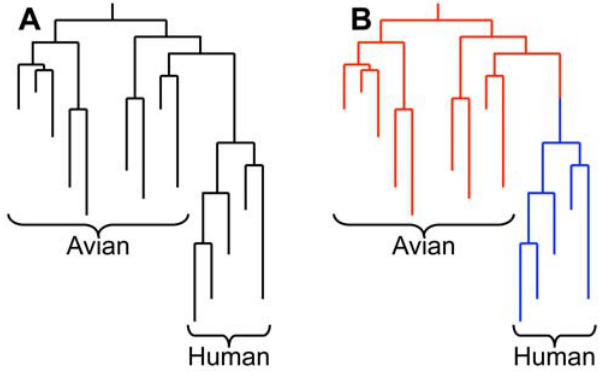
Figure 2. Homogeneous and non-homogeneous substitution models. Illustrative phylogenetic trees showing set of avian and human influenza sequences. A: In the homogeneous models (Models 1 and 2), the same substitution rates are used throughout the tree. B: In the non-homogeneous models (Models 3 and 4) different substitution rates are used for the avian (red) and human (blue) lineages. The root of the tree is assumed to be inside the avian lineage. (Because the model is reversible within the avian clade, the exact location of the root within this clade does not affect the calculation.) The host shift event is assumed to occur at the midpoint of the branch connecting the common ancestor of the human strains with its parent.